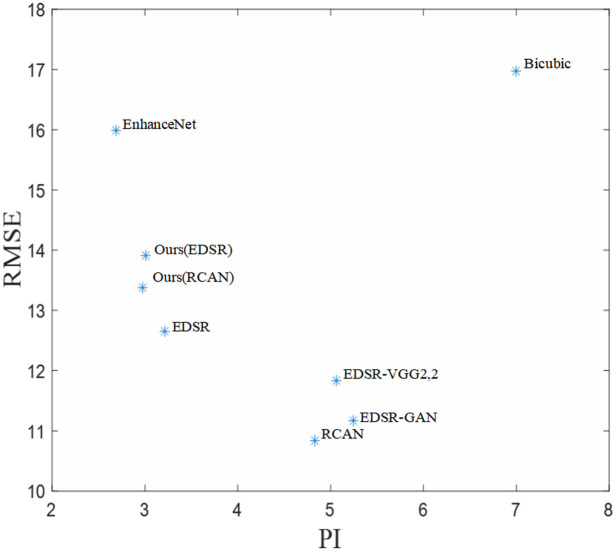
Scatter graph of RMSE versus PI for our methods and others (Bicubic, EnhanceNet, EDSR, RCAN, EDSR-GAN, EDSR-VGG2,2), where a low PI value indicates better perceived quality and a small RMSE value indicates better absolute quality.